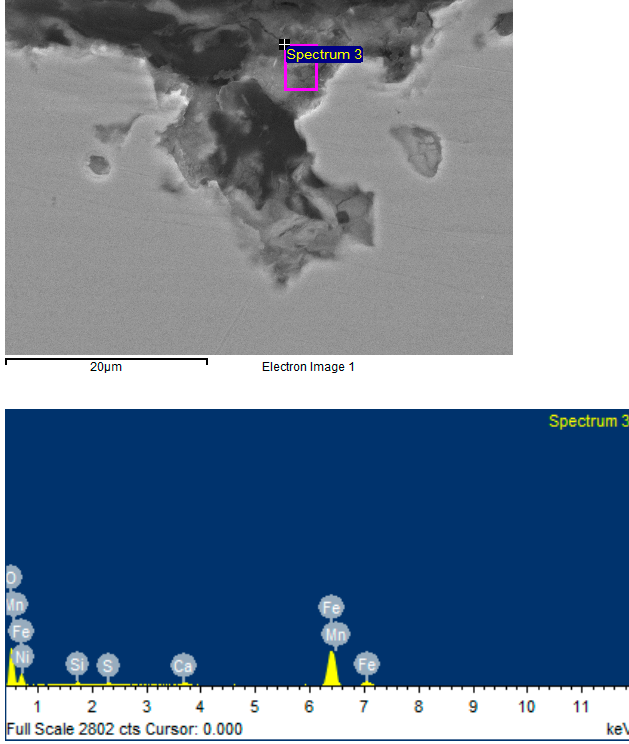
Figure 9. Image of the sample (test speed 500 rpm) surface (top left) and the change in elemental composition as a function of removal for carbon (top right), oxygen (bottom left), and iron (bottom right).